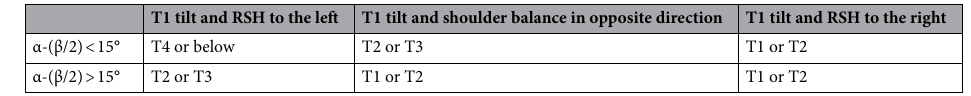
Table 1. Ilharreborde recommendation modified by Bjerke et al. α is the Cobb angle of the proximal thoracic curve on lateral bending towards the convex side (left side). β is the Cobb angle of the main thoracic curve on lateral bending towards the convex side (right side). RSH radiographic shoulder height.